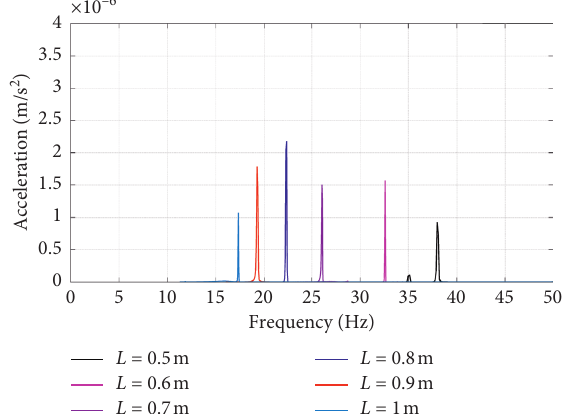
Figure 8: The first-order frequency of the FATMD with different spans ( r � 5mm).